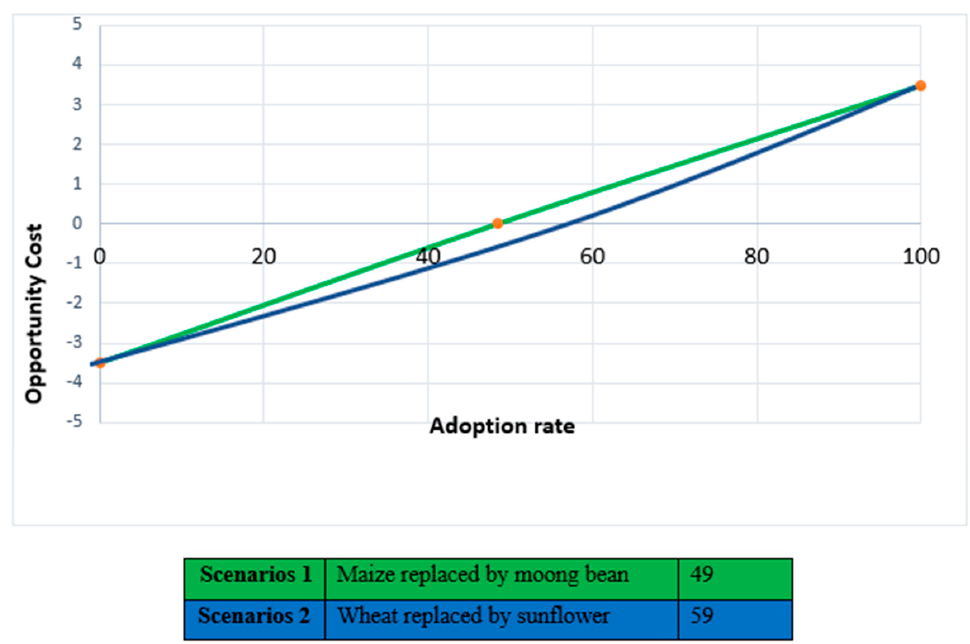
Figure 7. Potential adoption rate of low-delta crops in study area for a future agricultural production system. The percentage change in net farm returns per capita income and farm poverty due to crop substitution is shown in Figure 8.